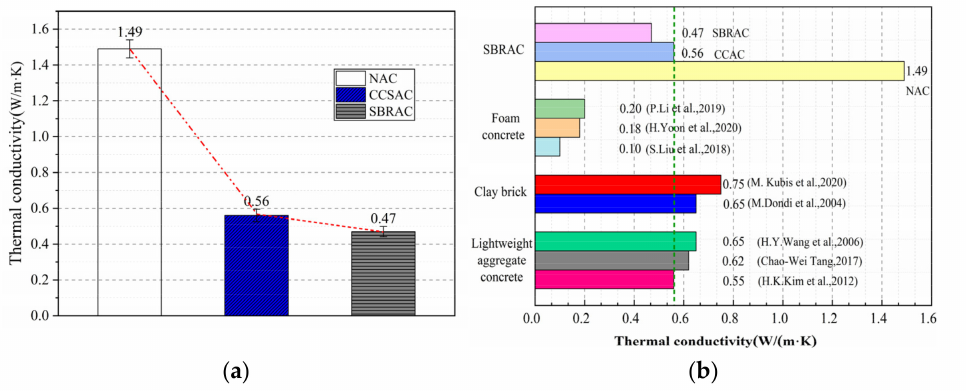
Figure 8. ( a ) Thermal conductivity of different types of concrete. ( b ) Comparison of thermal conduc- tivity of different wall insulation materials.